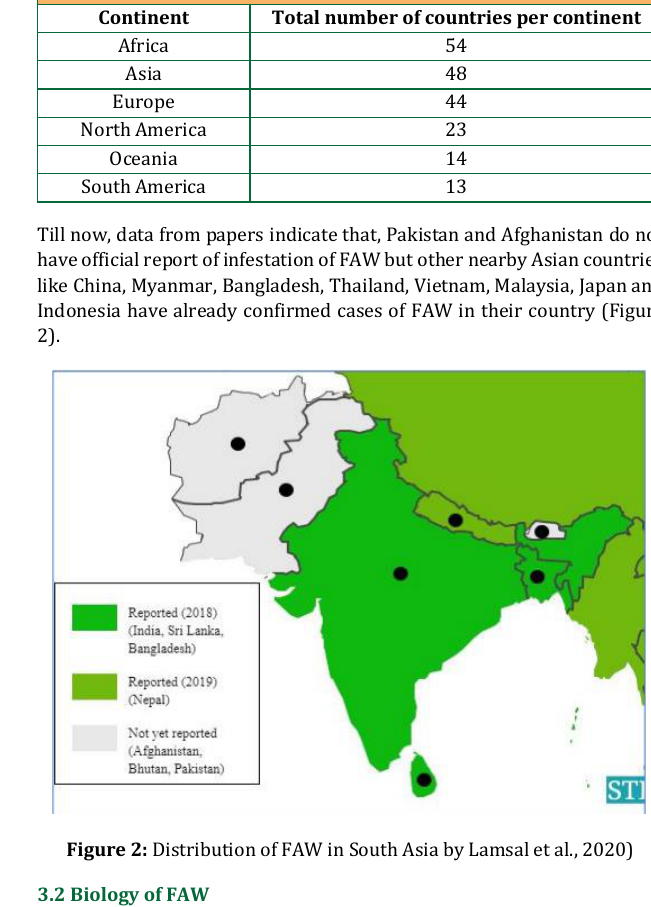
Table 1: Global distribution of Fall Armyworm by Adhikary et al.,